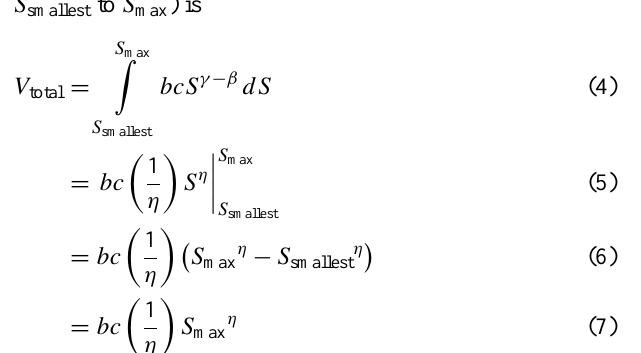
Fig. 4. Locations of the 10 subregions of British Columbia whose glacier distributions are plotted in Fig. 3. Gray dots on the map cor- respond to the locations of glaciers within each